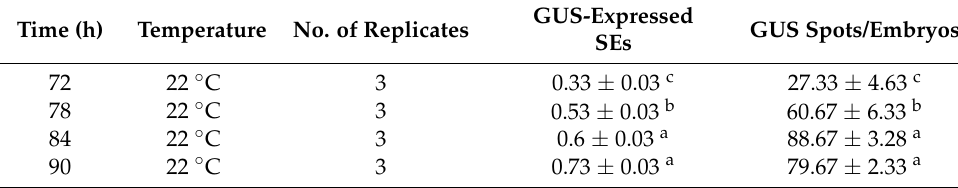
Table 3. Screening of cocultivation time for GUS expression below 22 ◦